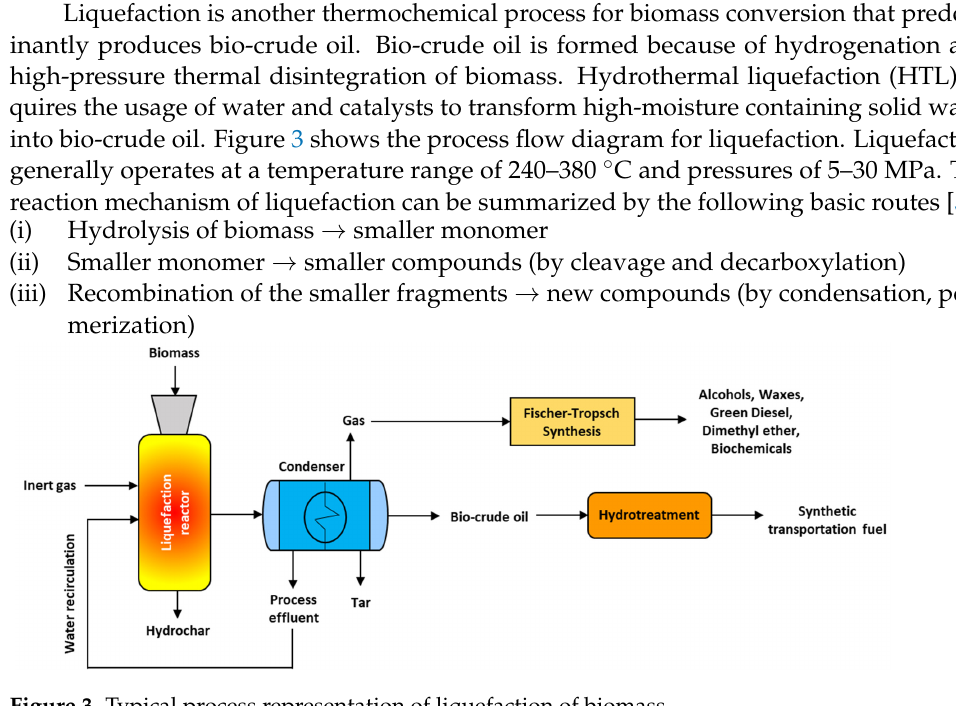
and biochemicals (as discussed earlier) can be recycled back and utilized as a solvent in the process [60]. Bio-crude obtained from liquefaction requires minimal upgrading by hy- drotreating unlike pyrolysis-derived bio-oil because of low oxygen content, more hydro- carbon yields, better energy density and flowability. Table 4 shows some promising stud- ies on the liquefaction of biomass to bio-crude oil. Table 4. Summary of notable works on liquefaction of waste biomass.